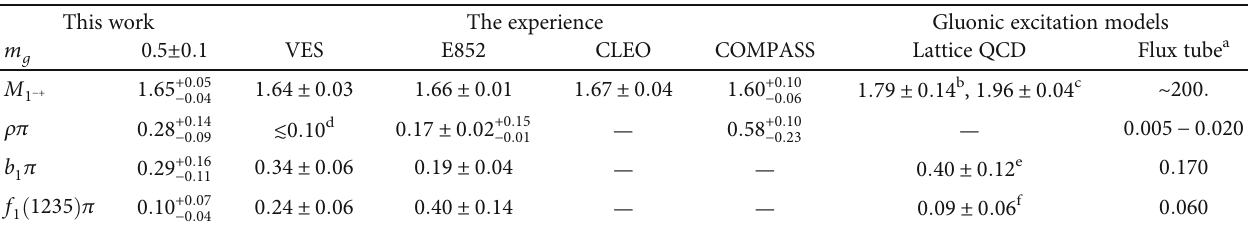
Table 4: Our 1 − + hybrid masses and the decay widths (in GeV) compared to the lattice QCD and fl ux tube results. Constituent glue model (this work) 0.10 a Selection rule. b Selection rule. c Selection rule. d Allowed beyond the nonrelativistic approximation. Calculations of this contribution will be the subject of future work. Table 5: The comparison of our work with data and the recent gluonic excitation models. This work The experience Gluonic excitation models E852 CLEO COMPASS Lattice QCD Flux tube